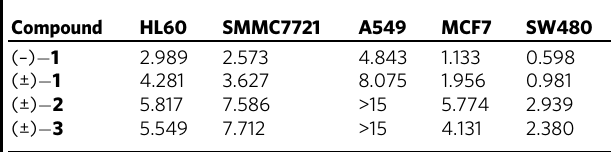
values as low as 0.598 μ M. Synthetic (±) − 1 exhibited ~60 – 70% ef fi cacy of ( – ) − 1 , and synthetic (±) − 2 and (±) − 3 exhibited similar levels of ef fi cacy with moderate IC 50 values. These in vitro